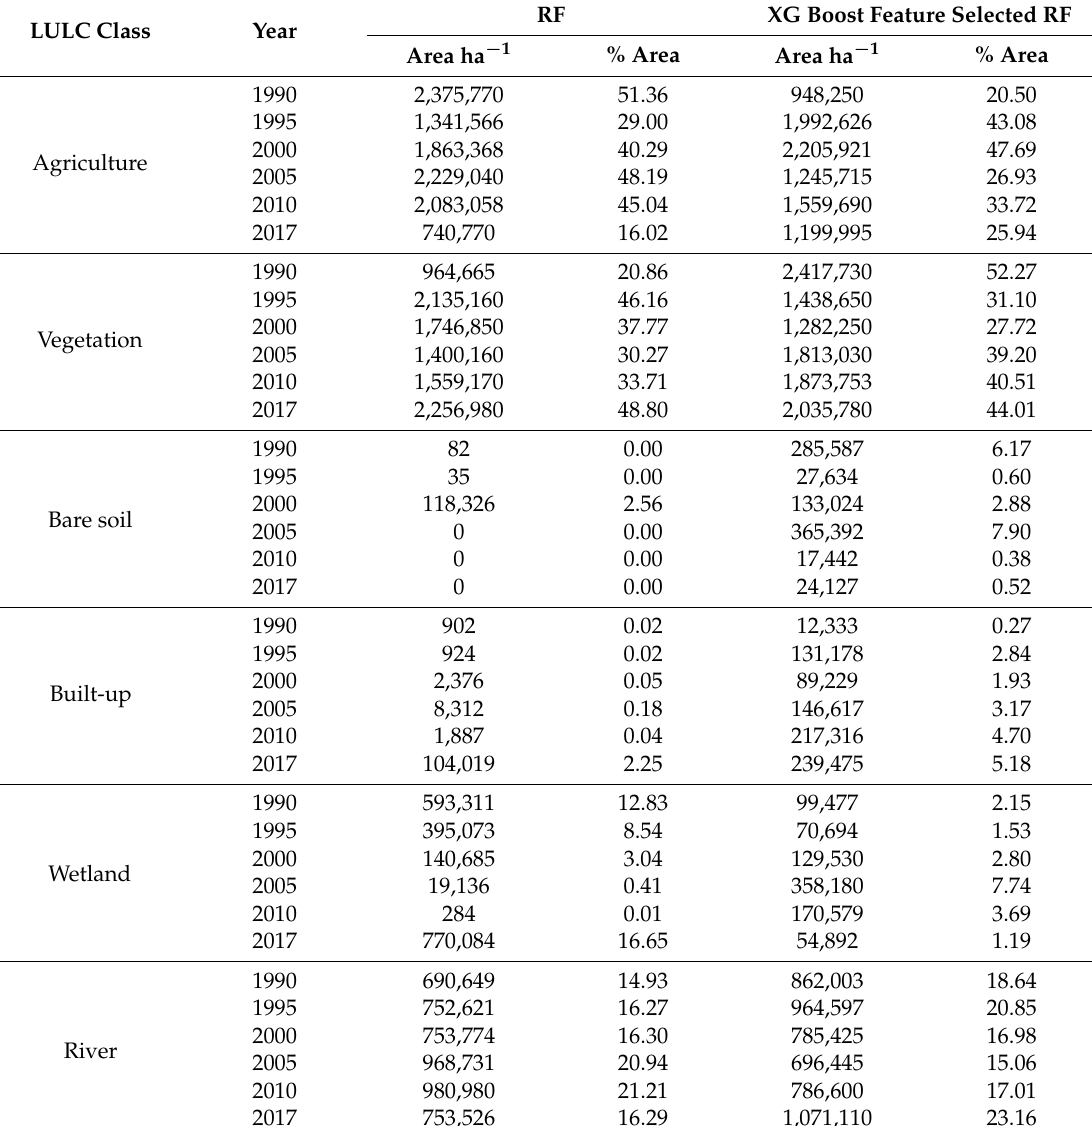
Table 7. Comparison of RF and XGBoost-feature selected RF